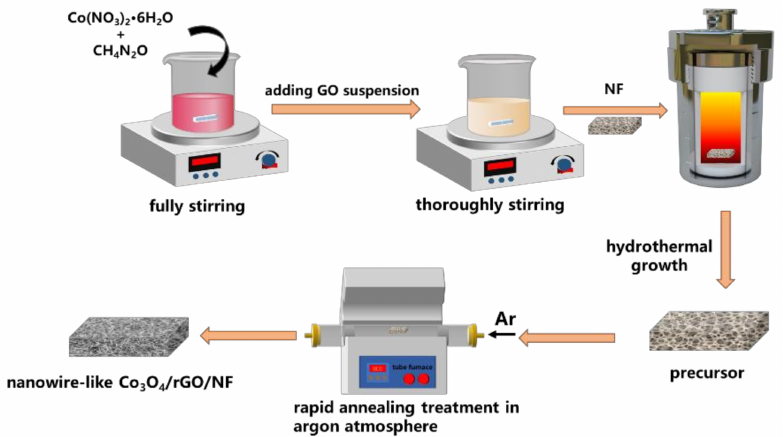
Figure 1. Schematic illustration of the preparation process of growing Co 3 O 4 /rGO on